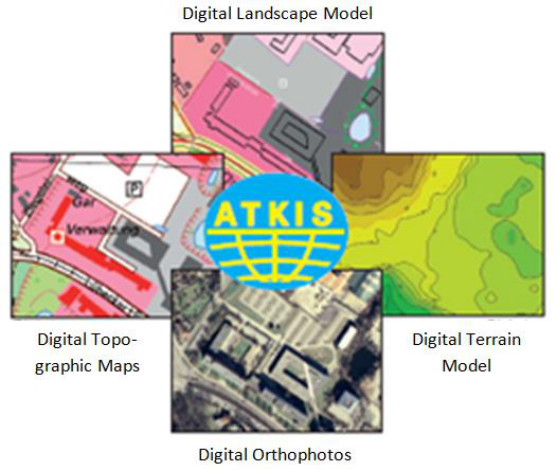
Figure 2. Authorative Topographic-Cartographic Information System ATKIS